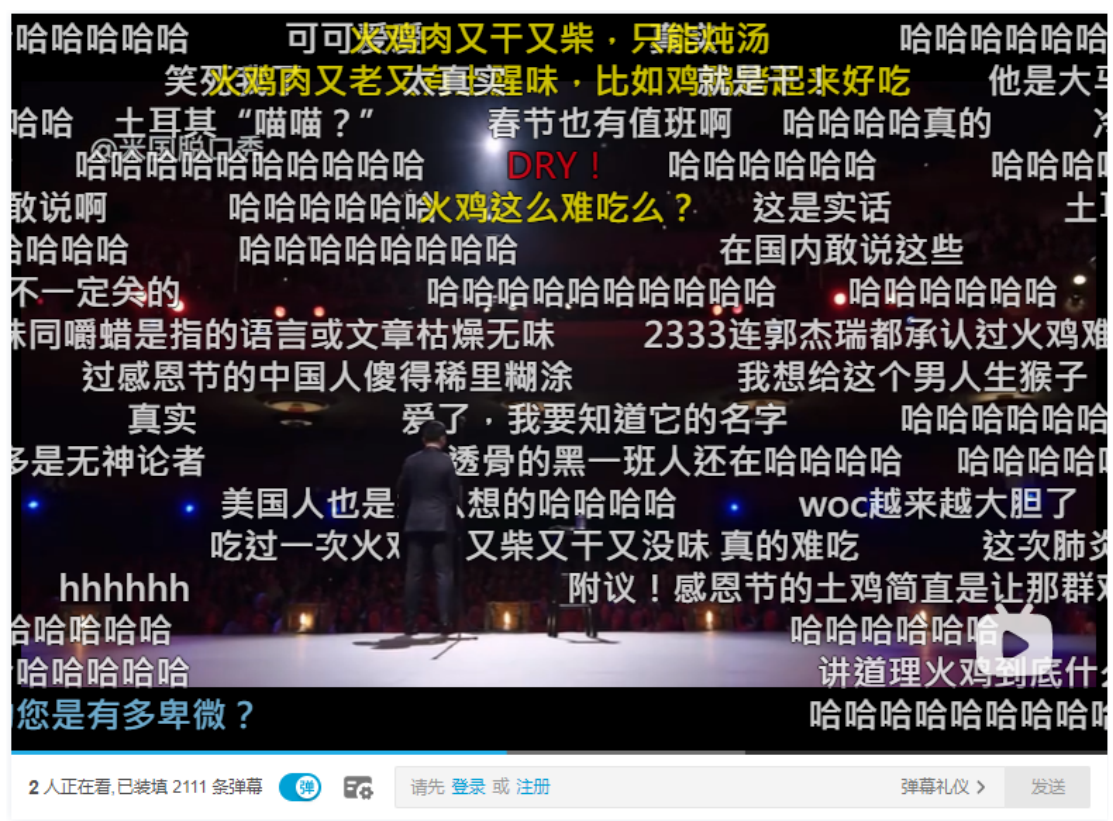
Figure 4. Turkey